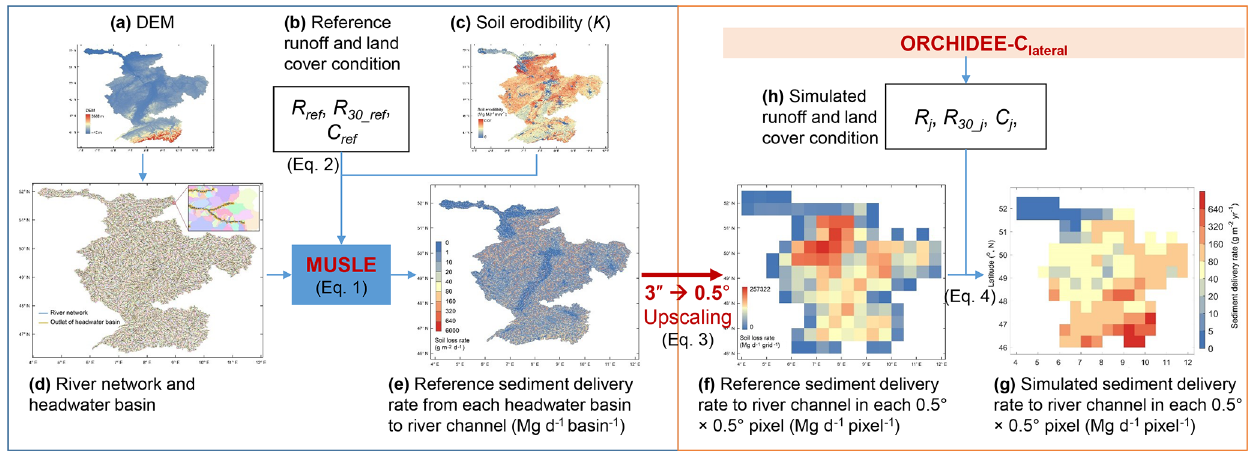
Figure 1. Upscaling scheme used in ORCHIDEE-MUSLE (Zhang et al., 2020) and ORCHIDEE-C lateral for calculating the sediment delivery rate from headwater basins to river networks. MUSLE is the Modified Universal Soil Loss Equation; DEM is the digital elevation model (m); K is the soil erodibility factor (MgMJ − 1 mm − 1 ); R ref is the assumed reference daily runoff depth (10mmd − 1 ); R 30_ref is the assumed reference maximum 30min runoff depth (1mm30min − 1 ); C ref (0 . 1, dimensionless) is the assumed reference cover management factor;